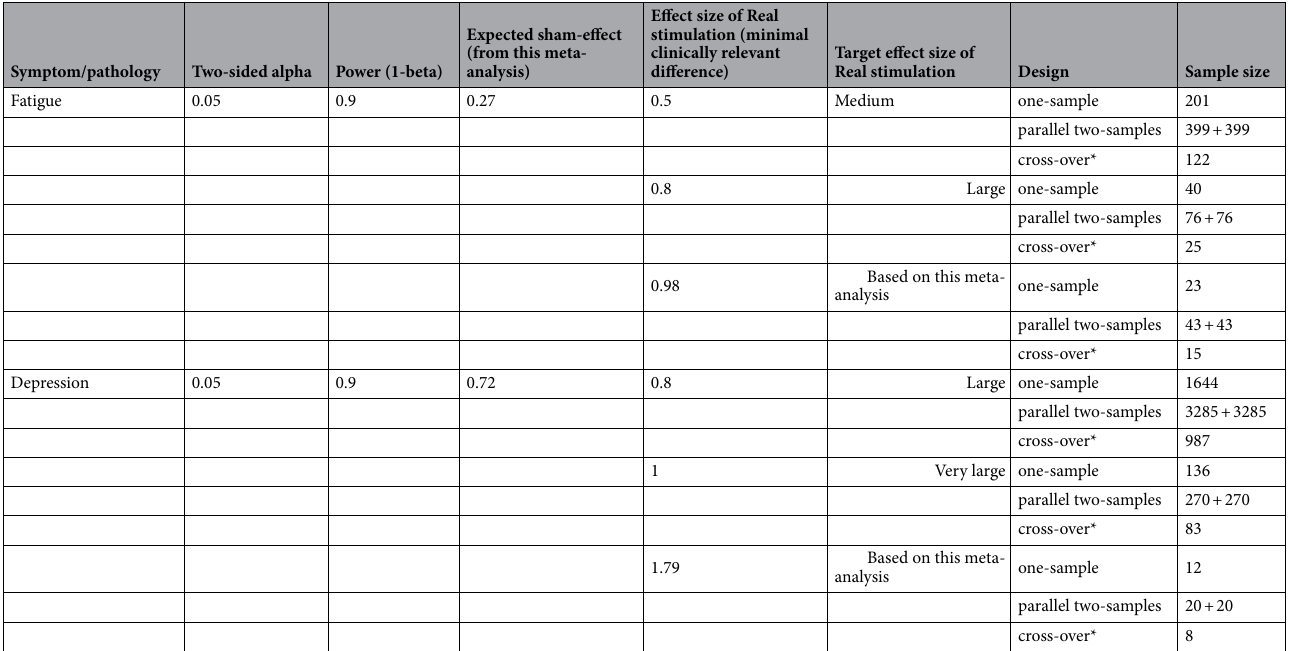
Table 15. Sham Power Analysis. Sample size estimation for different effect size of Real stimulation vs. estimated effect size of Sham stimulation, according to the present meta-analysis. Sham effect size in fatigue resulted = 0.27, thus effect size of Real stimulation was set at 0.5 (medium) and 0.8 (large). Sham effect size in depression resulted = 0.72, thus effect size of Real stimulation was set at 0.8 (large) and 1.0 (very large). In addition, the effect size of Real stimulation (estimated with this meta-analysis) was considered in order to indicate that effects of this magnitude (and thus also smaller) could be considered realistic. * a correlation